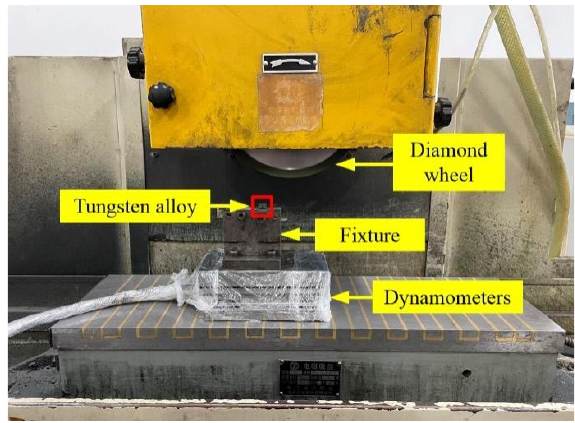
Figure 6. Surface grinding setup. Table 3. Grinding parameters.